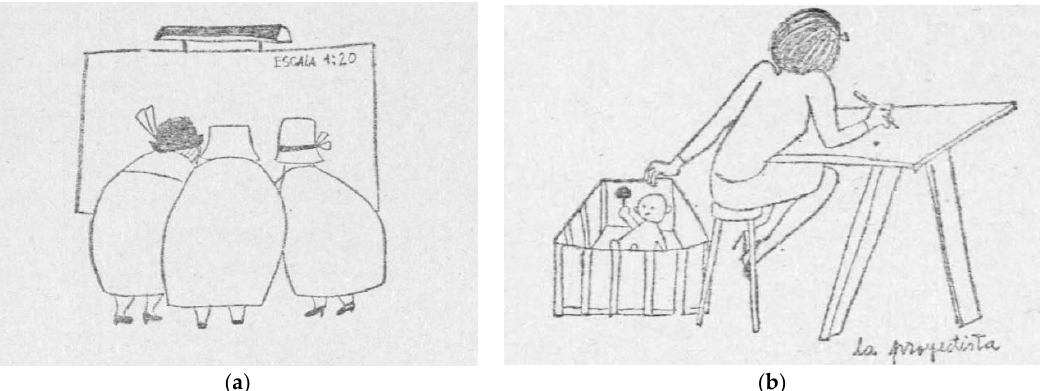
Figure 1. Drawings that accompanied the article by Elena Arregui on the First International Women’s Congress, Bad Godesberg, 1963: ( a ) the opinion of women; ( b ) the female architect. Images used with permission.